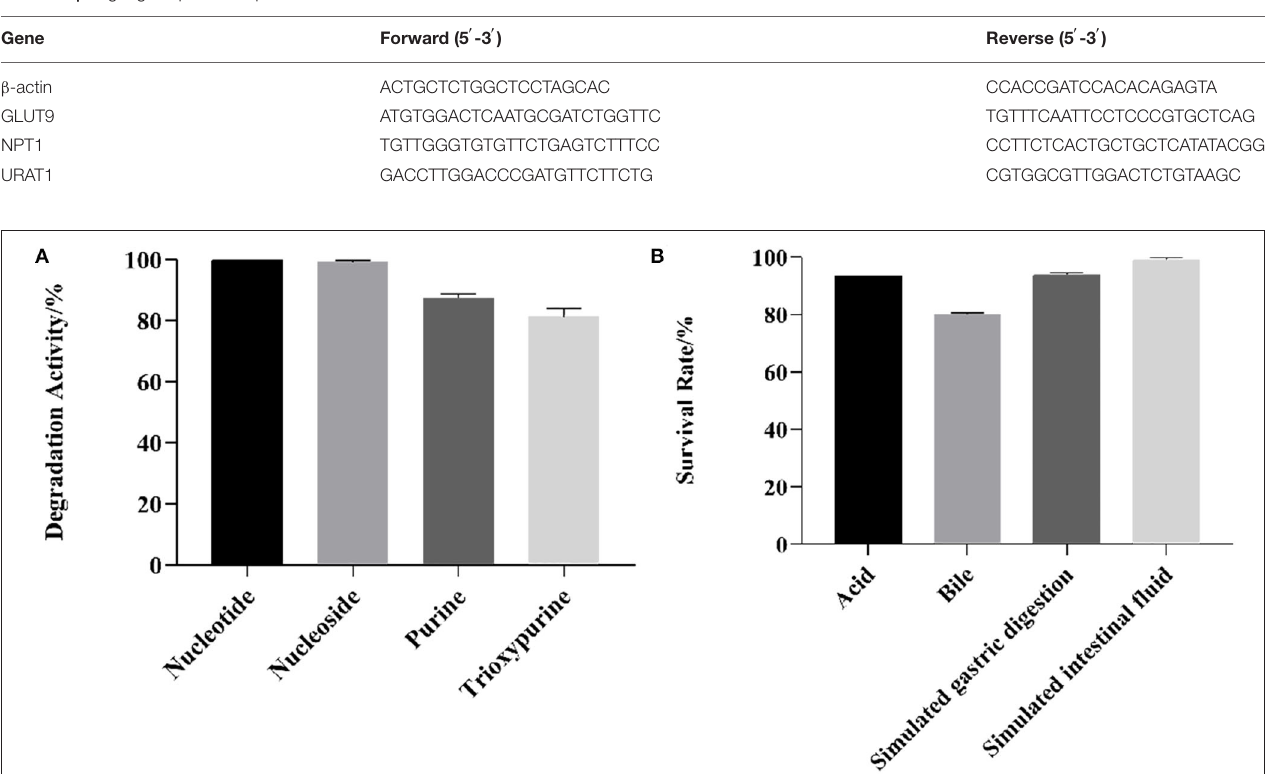
FIGURE 2 | Determination of UA-lowering activity and gastrointestinal tolerance of L. plantarum Q7. (A) UA-lowering activity; (B) Gastrointestinal tolerance.